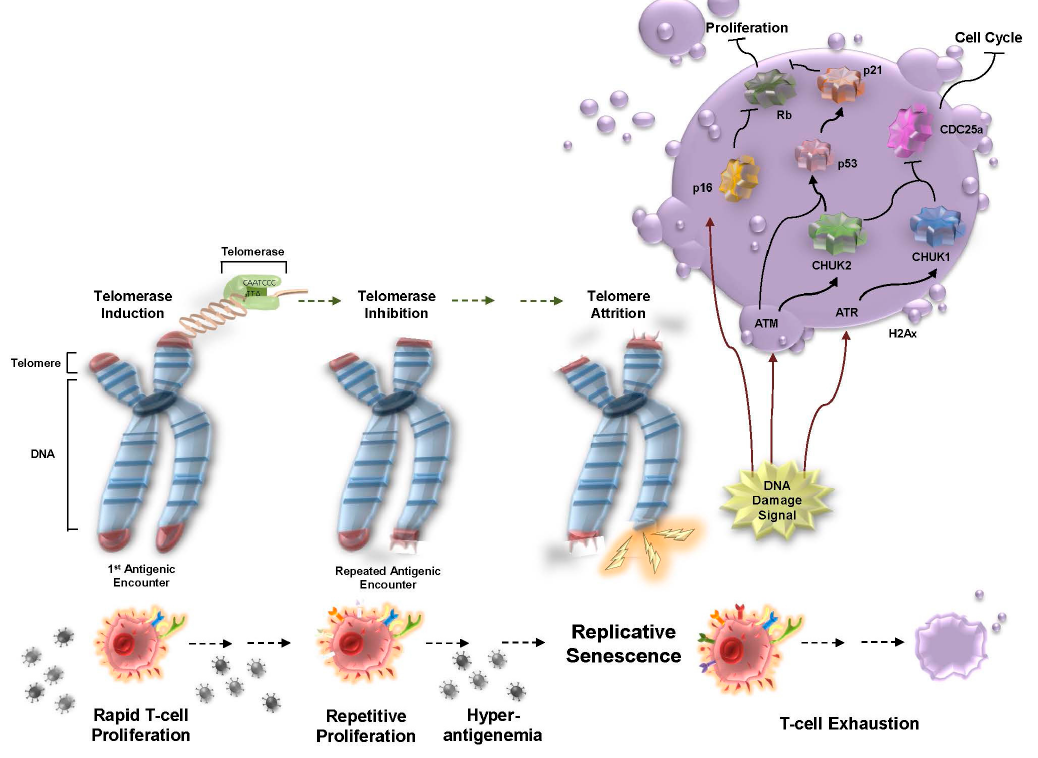
Figure 3. Telomere attrition and the DNA damage response during chronic viral infection. During an initial viral encounter, a robust T-cell response occurs followed by telomerase activation and retention of telomere lengths. Subsequent antigen encounters lead to inactivation of the telomerase promoter and loss of telomerase expression. Telomere attrition, caused by chronic exposure to viral antigen, is exacerbated over time (dotted arrows). Enduring hyper-antigenemia results in telomere crisis and the activation of the DNA damage signal. This results in T-cell exhaustion, inhibition of T-cell proliferation, and cell cycle arrest. The eventual outcome is programmed cell death (apoptosis) or replicative senescence. (Abbreviations: ATM, ATM Serine/Threonine Kinase; ATR, ATR Serine/Threonine Kinase; CDC25a, Cell Division Cycle 25A; CHUK-1/2, Conserved Helix-Loop-Helix Ubiquitous Kinase-1/2; H2AX, H2A Histone Family Member X; p16, Cyclin Dependent Kinase Inhibitor 2A; p21,